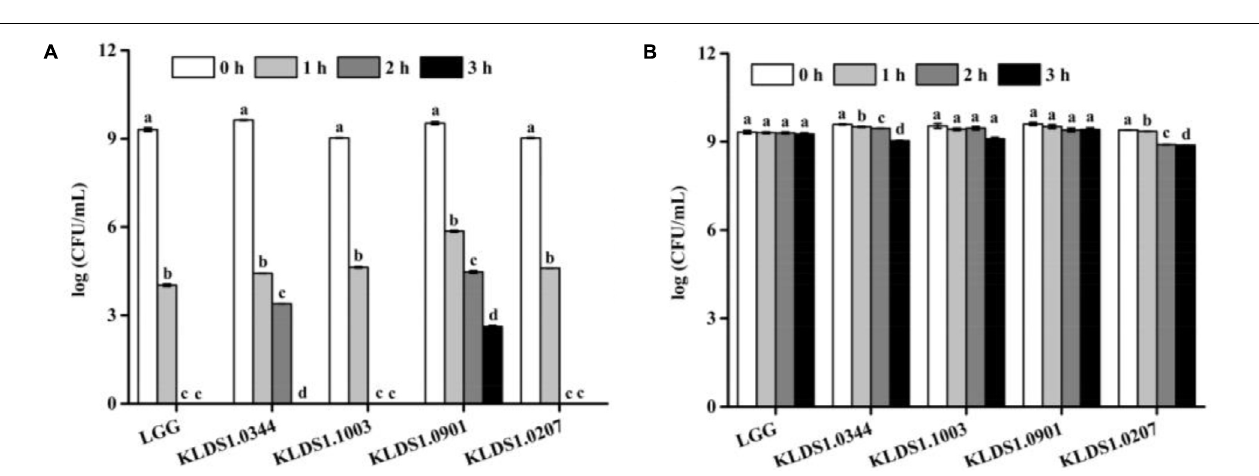
FIGURE 2 | Effect of pH 2.0 and pH 3.0 on viability of Lactobacillus strains. Graph (A) presents the effect of pH 2.0 on viability of Lactobacillus strains whereas Graph (B) presents the effect of pH 3.0 on viability of Lactobacillus strains. Values represent mean ± SD ( n = 3 independent experiments). Significant differences ( p < 0.05) among different groups are indicated with different superscript